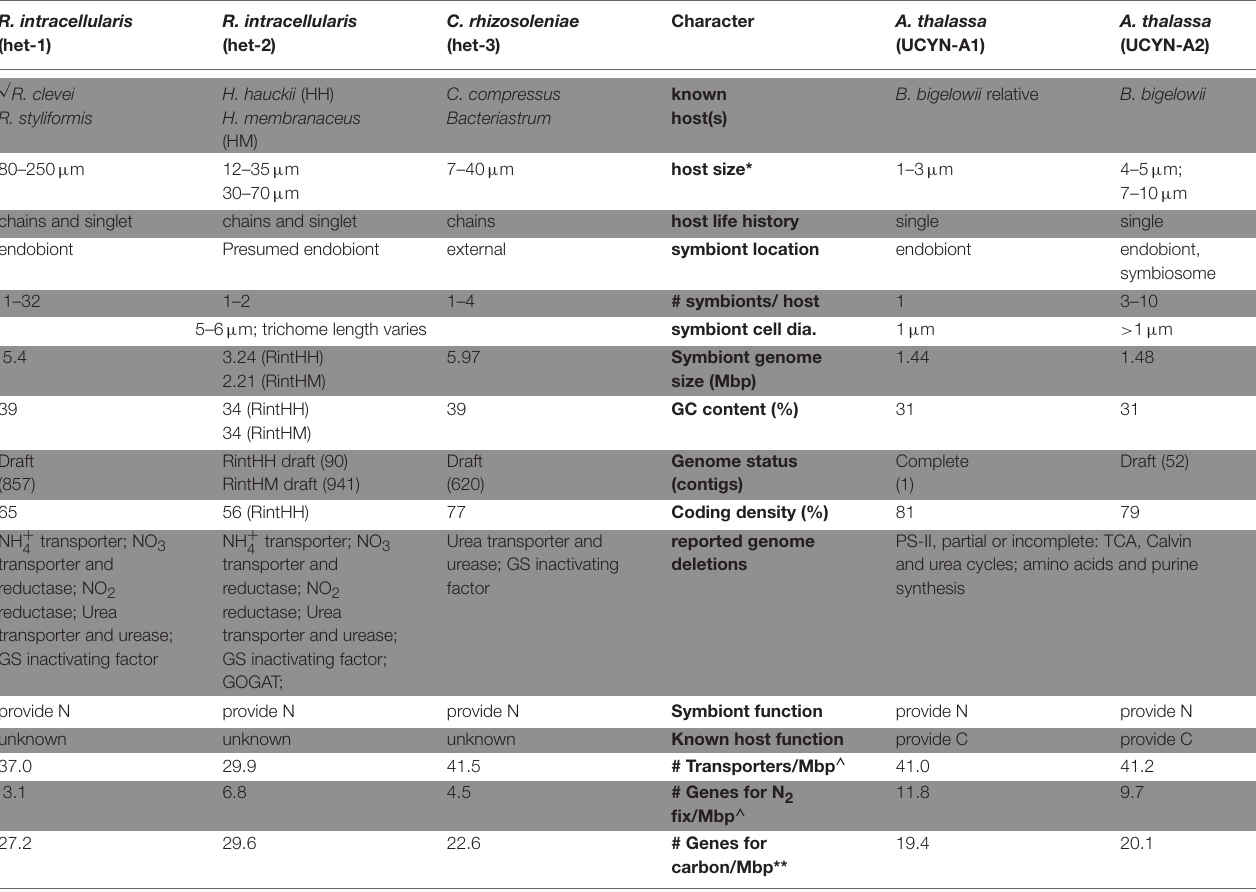
TABLE 1 | Summary of characters for DDA and Prymnesiophyte-UCYN-A symbioses are shown and separated by symbiont identity and common abbreviation for each symbiont is given in parenthesis (e.g. het-1) †